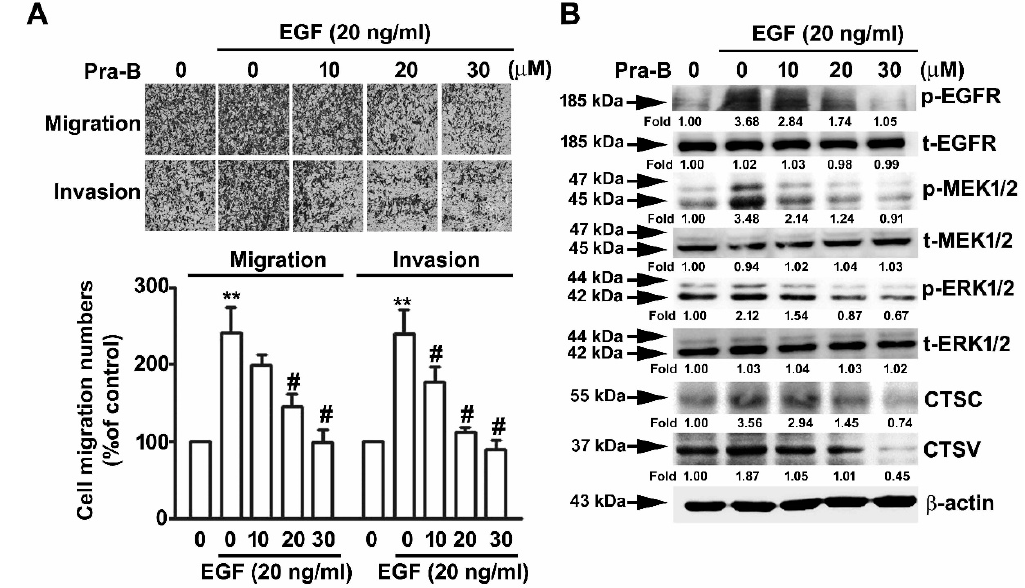
Figure 5. Pra-B attenuated epidermal growth factor-induced migration ability through the EGFR signaling pathway. The cells were pretreated with EGF (20 ng / mL) for 2 h and then incubated with various concentrations of Pra-B (0, 10, 20, and 30 µ M) for 24 h. ( A ) Cell migration and invasion were measured using an in vitro migration and Matrigel-based invasion assay. Quantification of migrating cells presented in terms of percentage of control (0 µ M) is shown as a histogram. ( B ) Cells were harvested to detect the p-EGFR, t-EGFR, p-MEK, t-MEK, p-ERK, t-ERK, CTSC, and CTSV protein expression levels through immunoblotting. β -actin was used as the loading control. The expression of these proteins was detected by densitometry as an average relative ratio compared to β -actin from three different experiments. ** p < 0.01 relative to the control. # p < 0.05 relative to EGF-treated alone. Data are presented in terms of mean ± SD, as determined in at least three independent experiments. Scale bar = 50 μ m.